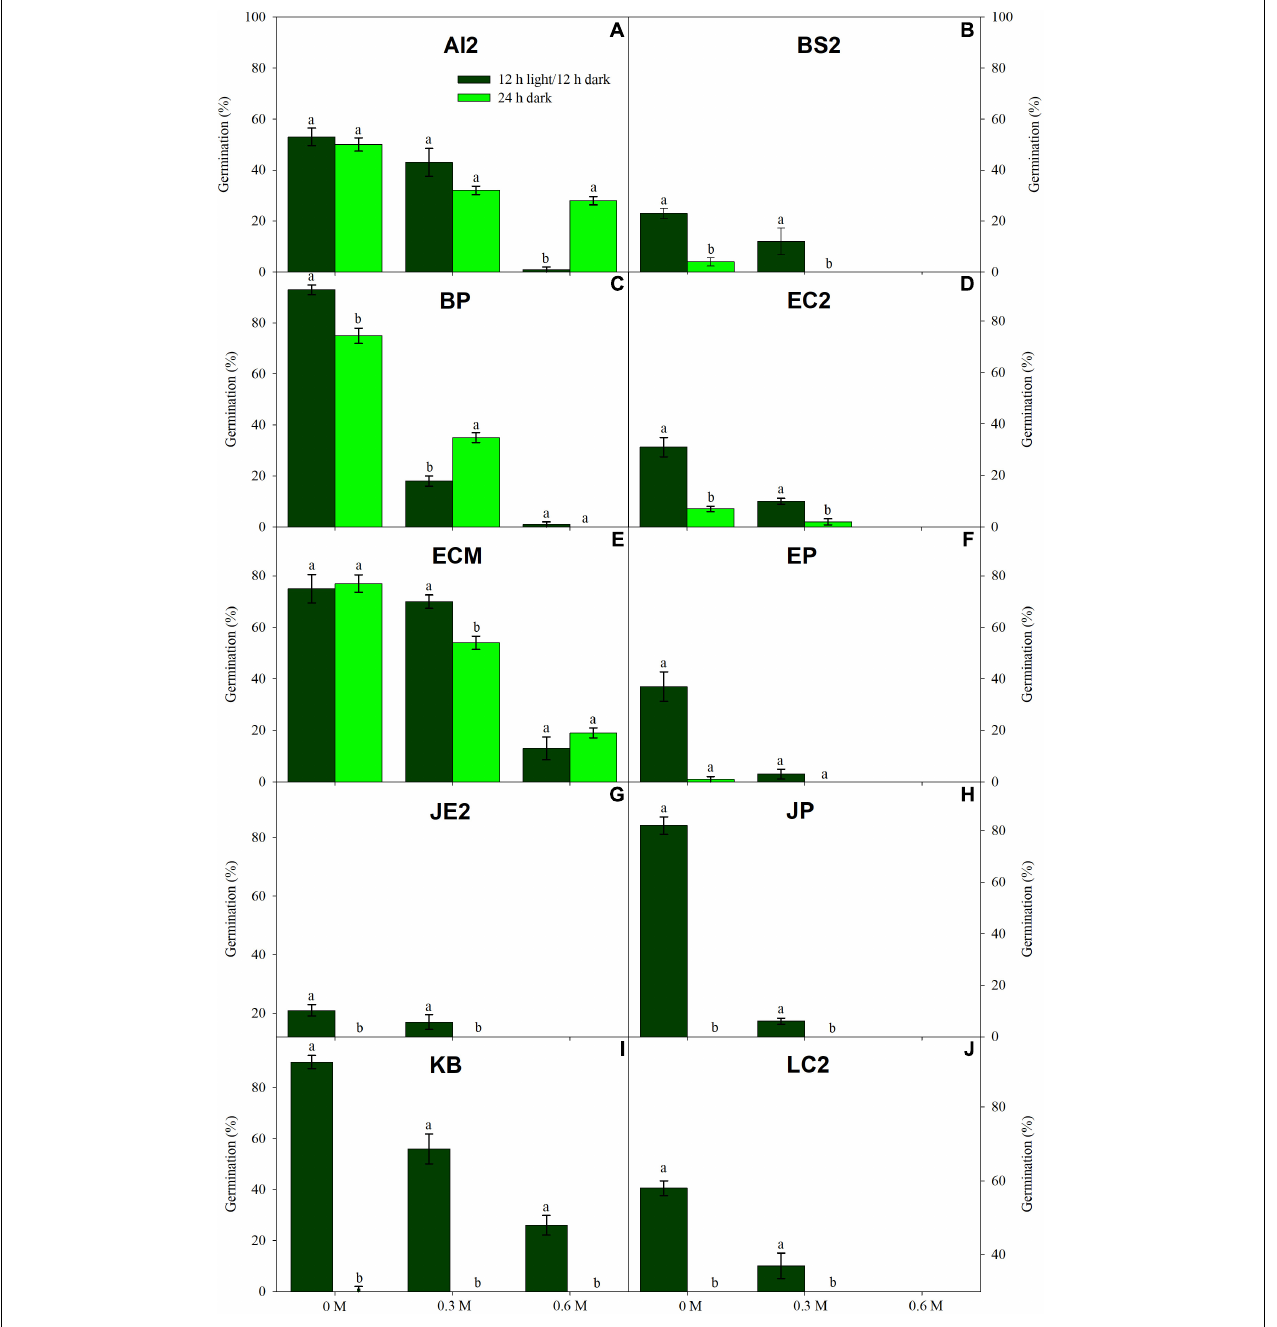
FIGURE 1 | Germination in light (dark green) and dark treatments (light green) under three PEG6000 concentrations for 10 wetland species occurring in Jiujiang, China. Vertical bars denote ± SE around the mean. Within features, different lowercase letters indicate significance at P ≤ 0.05. For more details on each study species, see Table 1